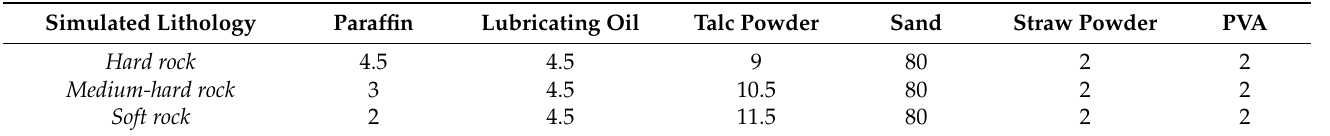
Table 1. Ratios of similar-simulation materials (%).